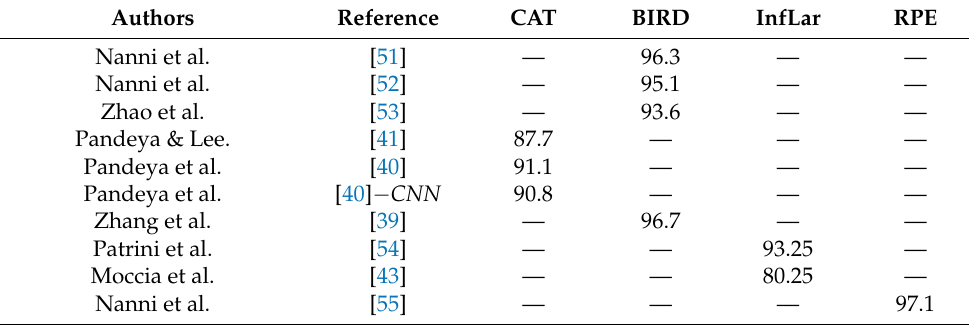
Table 6. Literature results